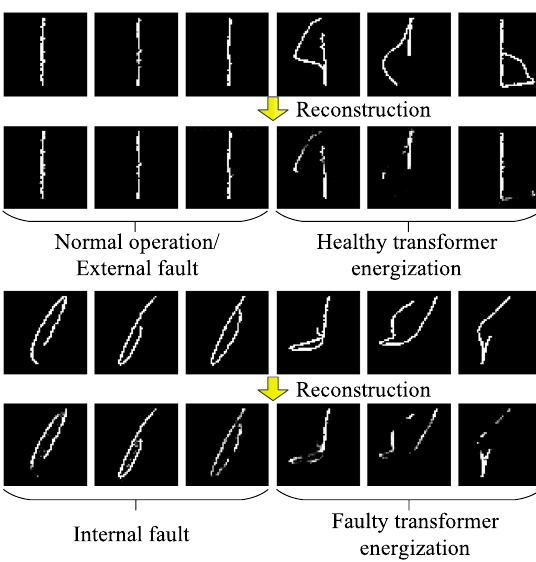
Fig. 10 Reconstruction results of test samples